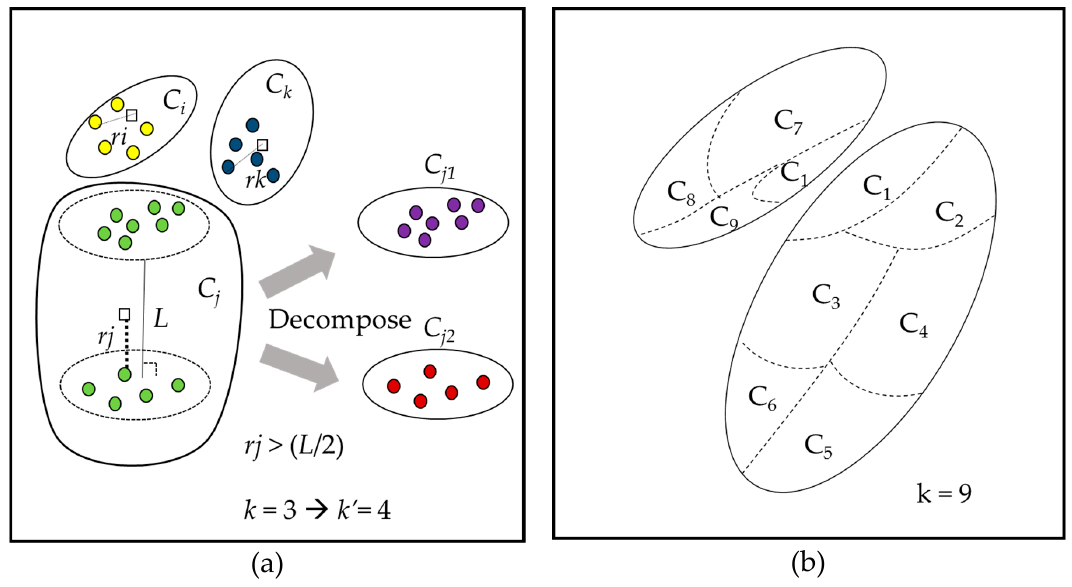
Figure 4. The algorithm for leaf segmentation. ( a ) The relationship between the distance r and the leaf gap distance ( L ). The k -value increased from 3 to 4 to decompose more segmented pieces to make r j > ( L / 2). ( b ) Example of the result of segmentation. C 1 represents invalid